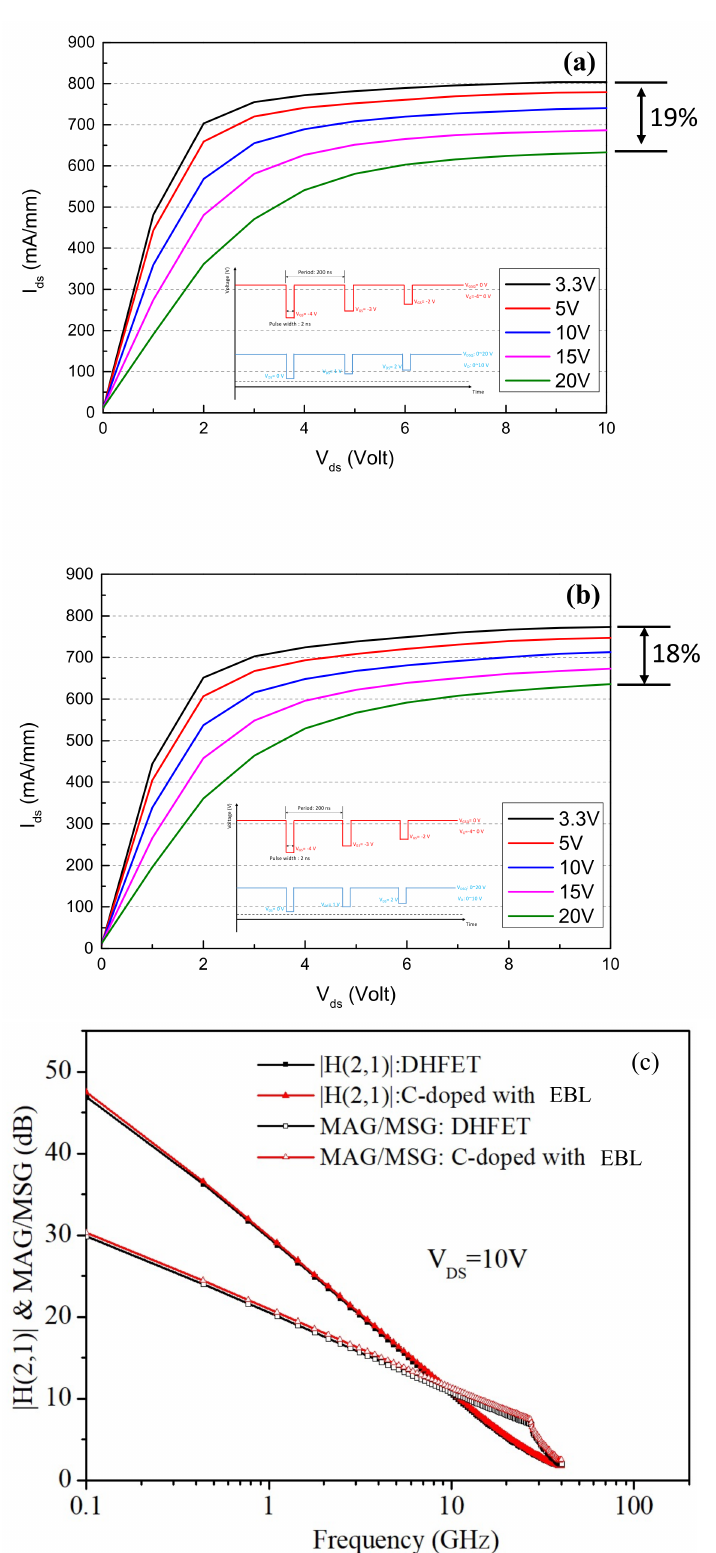
Figure 5. Pulsed I-V characteristics of the device with different buffers: the data show the drain lag under different drain biases (pulse width 200 ns, duty 1%); ( a ) the 2 × 50 µ m GaN:C/EBL buffer device; ( b ) the 2 × 50 µ m DHFETs; ( c ) MSG/MAG gain of the GaN:C/EBL buffer device and the DHFET (device size 8 × 50 µ